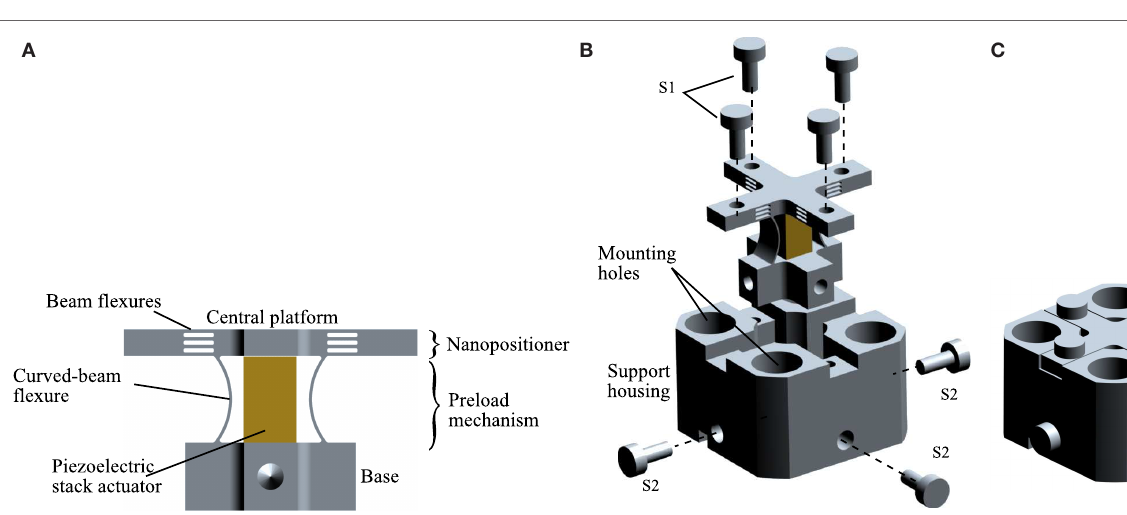
Fr ontiers in Mechanical Engineering |